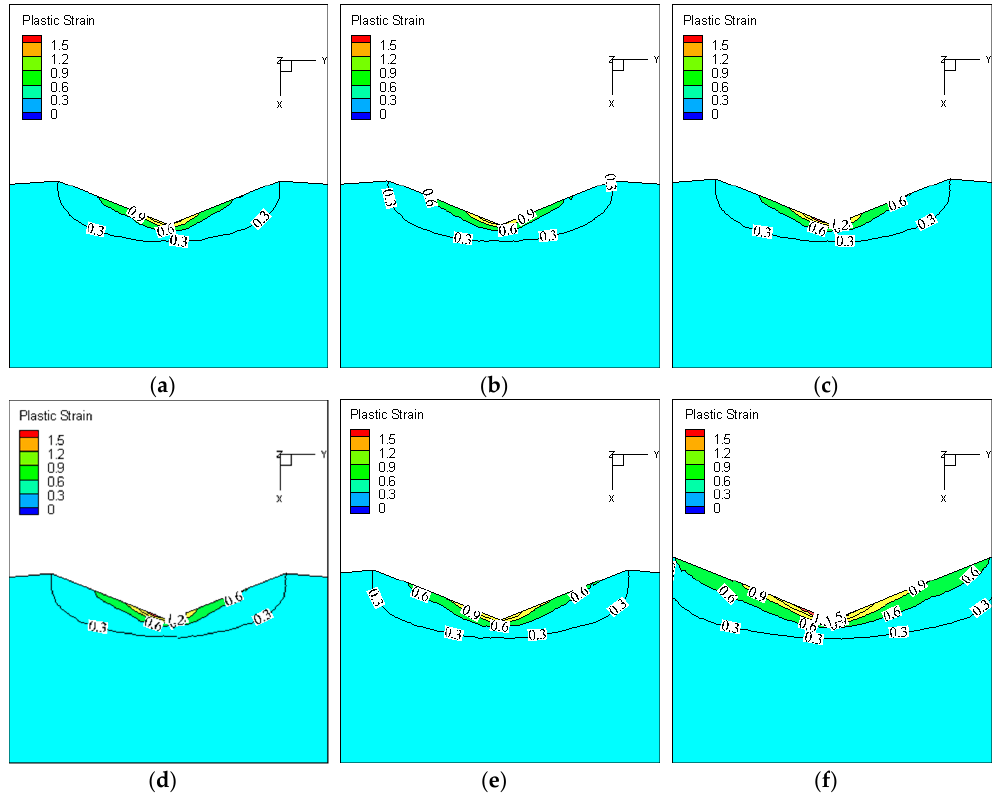
Figure 16. Strain contour of indentation section under different test temperatures (Load = 10 kg). ( a ) Temperature = 20 °C; ( b ) Temperature = 200 °C; ( c ) Temperature = 400 °C; ( d ) Temperature = 500 °C; ( e ) Temperature = 600 °C; ( f ) Temperature = 800 °C.